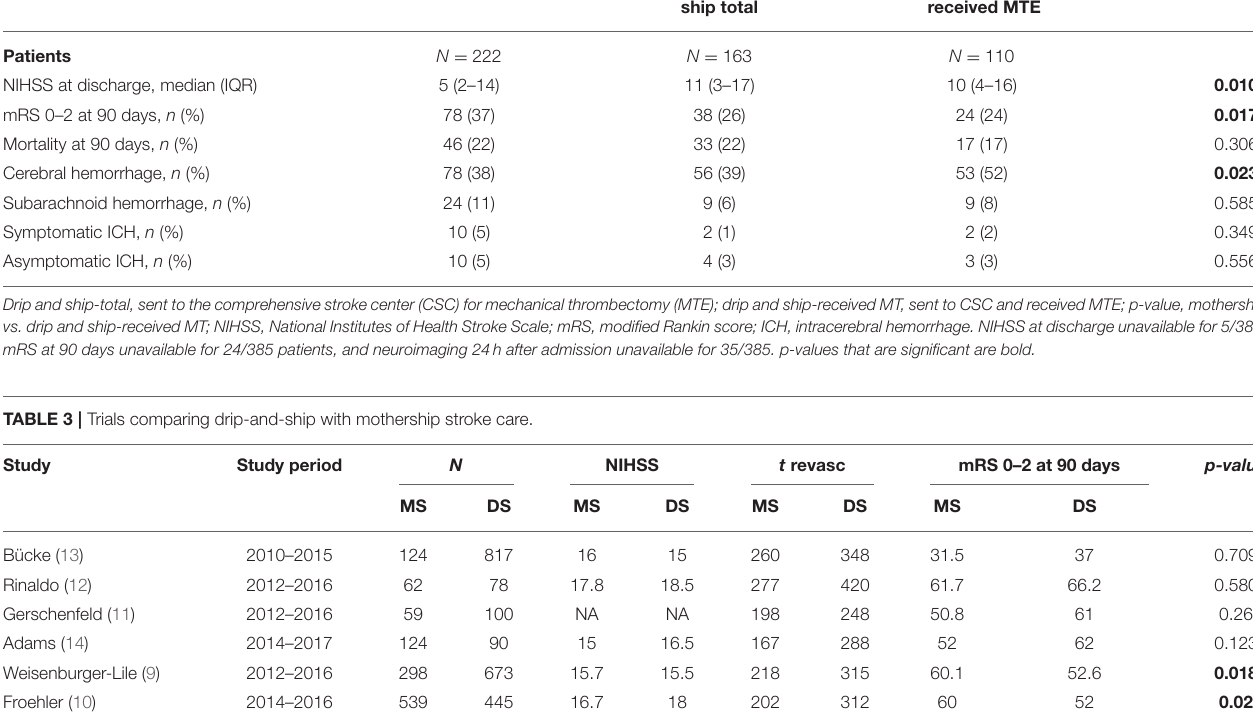
Mothership Drip and Drip and ship